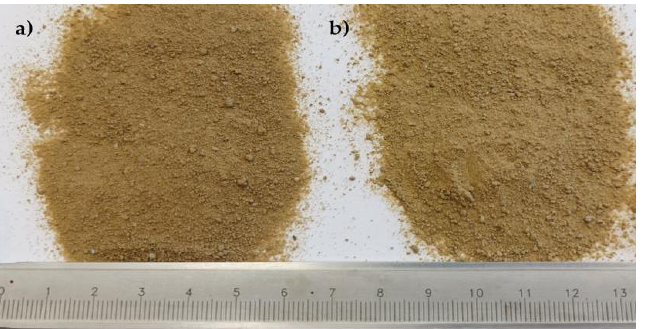
Figure 3. Macroscopic view comparison of reference silty sand samples: ( a ) f Si+Cl ,1 = 15.14% and ( b ) f Si+Cl ,2 = 20.48%.